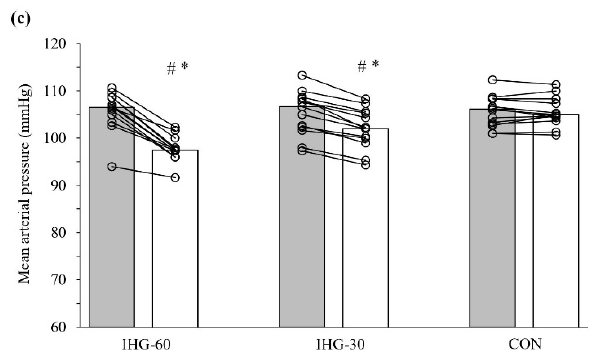
Figure 2. Blood pressure, pre- and post-intervention. Bars represent the pre- and post-intervention median: ( a ) systolic blood pressure, ( b ) diastolic blood pressure, and ( c ) mean arterial pressure for the groups. Paired scatterplots show individual changes for each participant. IHG-60 = isometric handgrip performed at 60% maximal voluntary contraction; IHG-30 = isometric handgrip per- formed at 30% maximal voluntary contraction; CON = control. # Significant difference compared to pre- ( p < 0.01); * Significant difference compared to CON ( p < 0.001); † Significant difference com- pared to IHG-30.